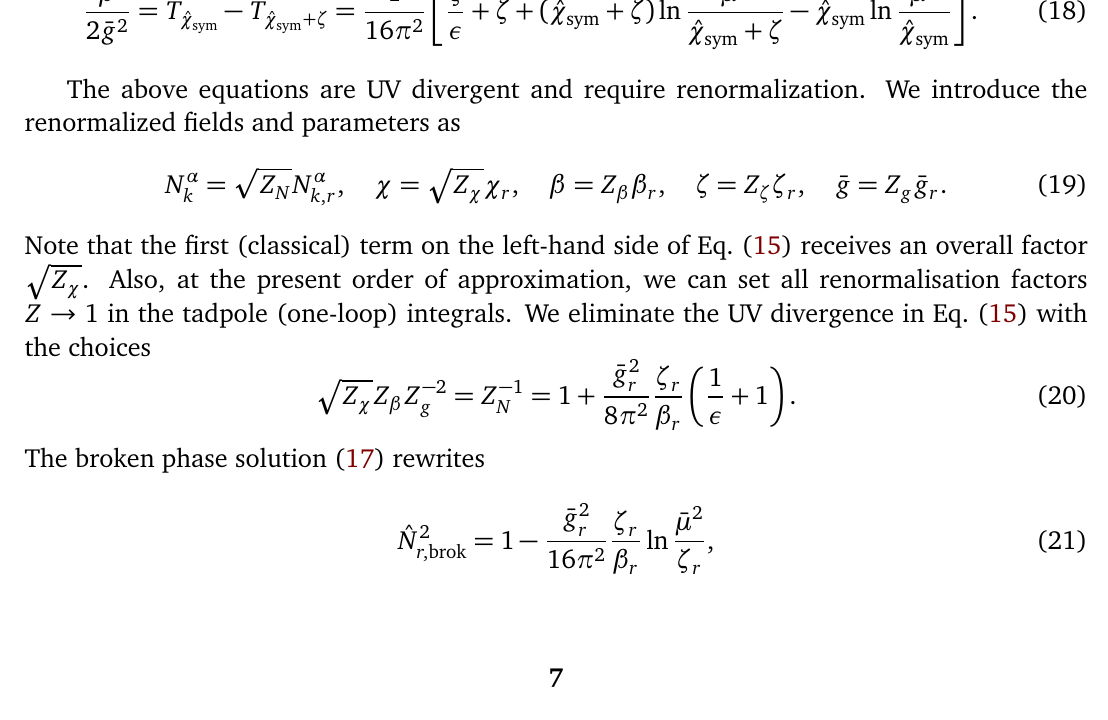
as a function of the gauge parameter ζ r ,sym / ¯ g 2 (in units of ¯ µ 2 ). The dashed curve is the r r ≥ 0 only exist in a range of parameters r ,sym